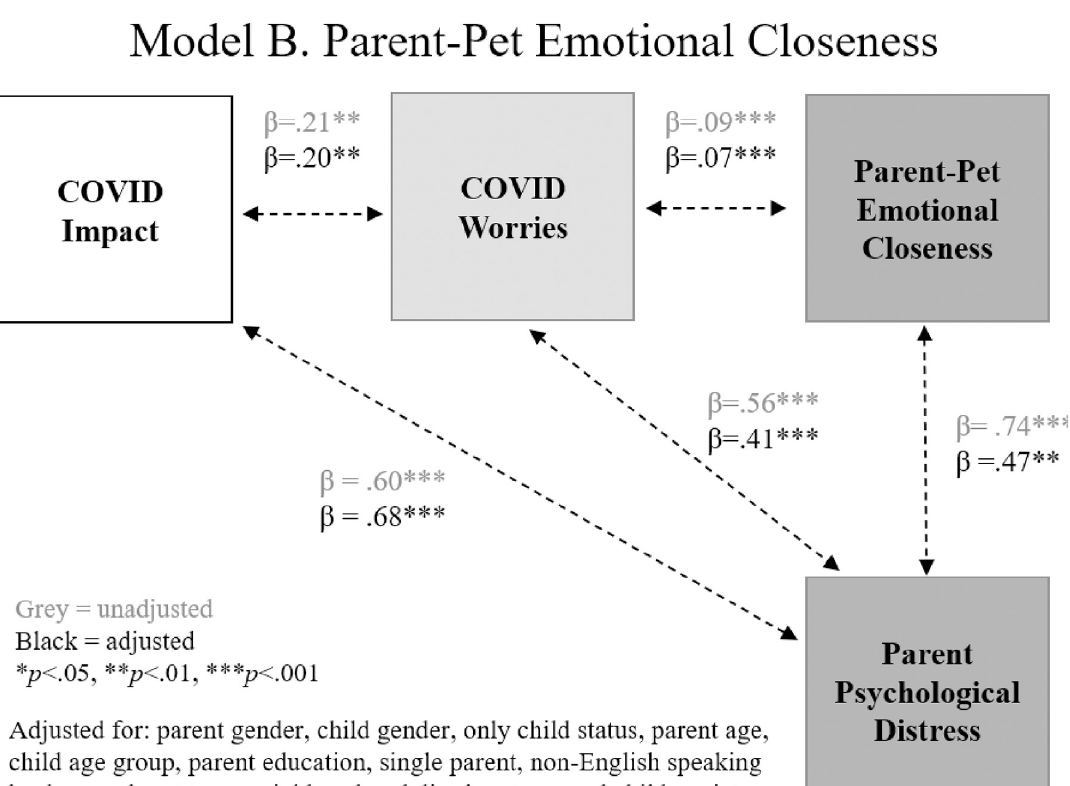
Fig 4. Model B: Associations between COVID-19 impact and worries, parent-pet emotional closeness and parent mental health.